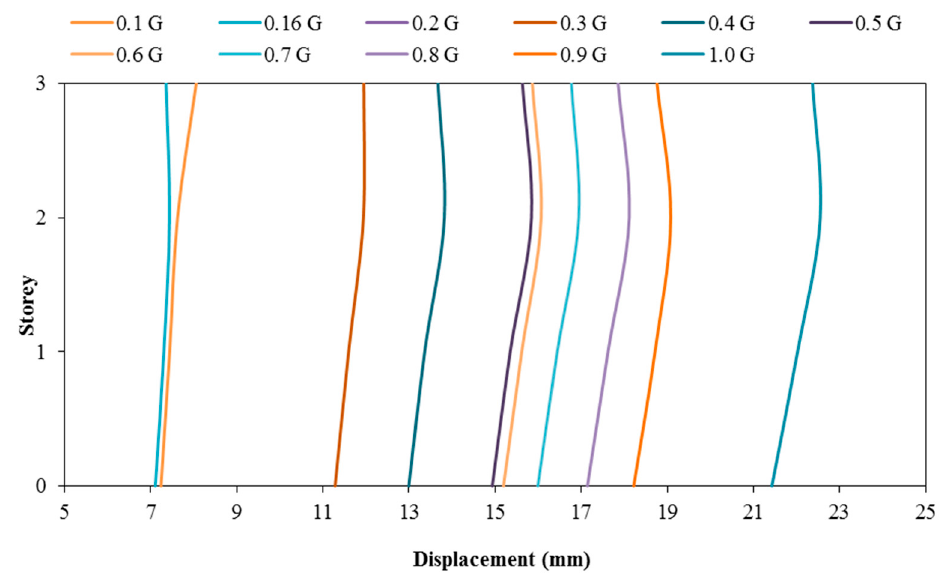
Figure 10. Storey drift of structure with dampers.